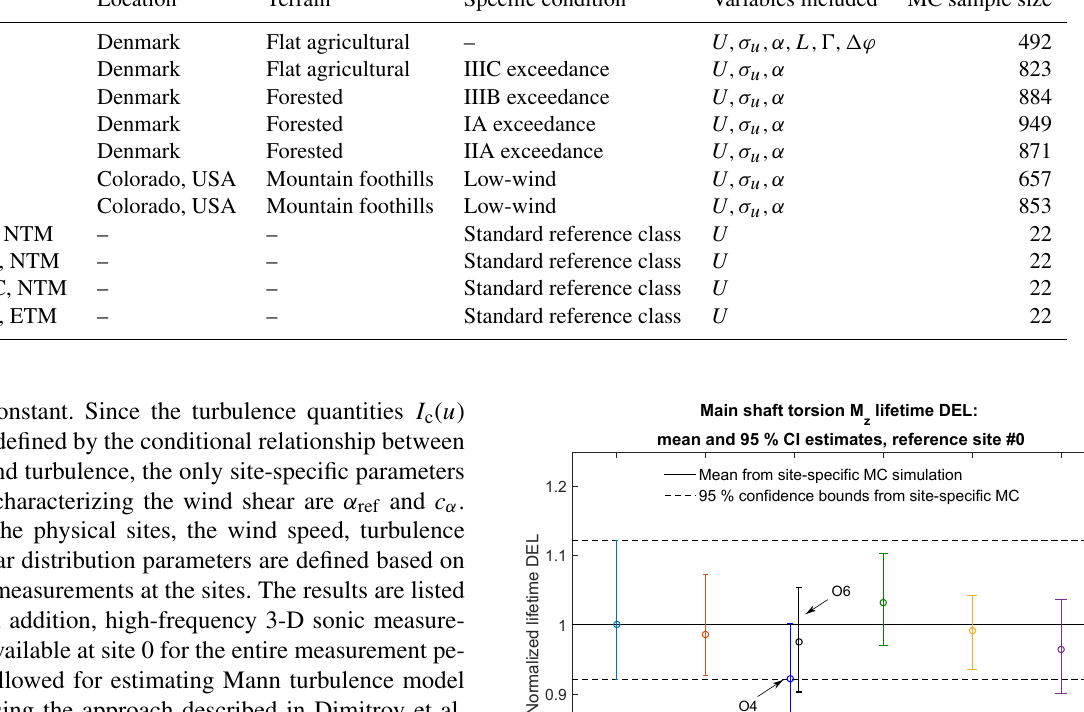
Table 5. Reference virtual sites used for validation of the site-specific load estimation methods. Site no.